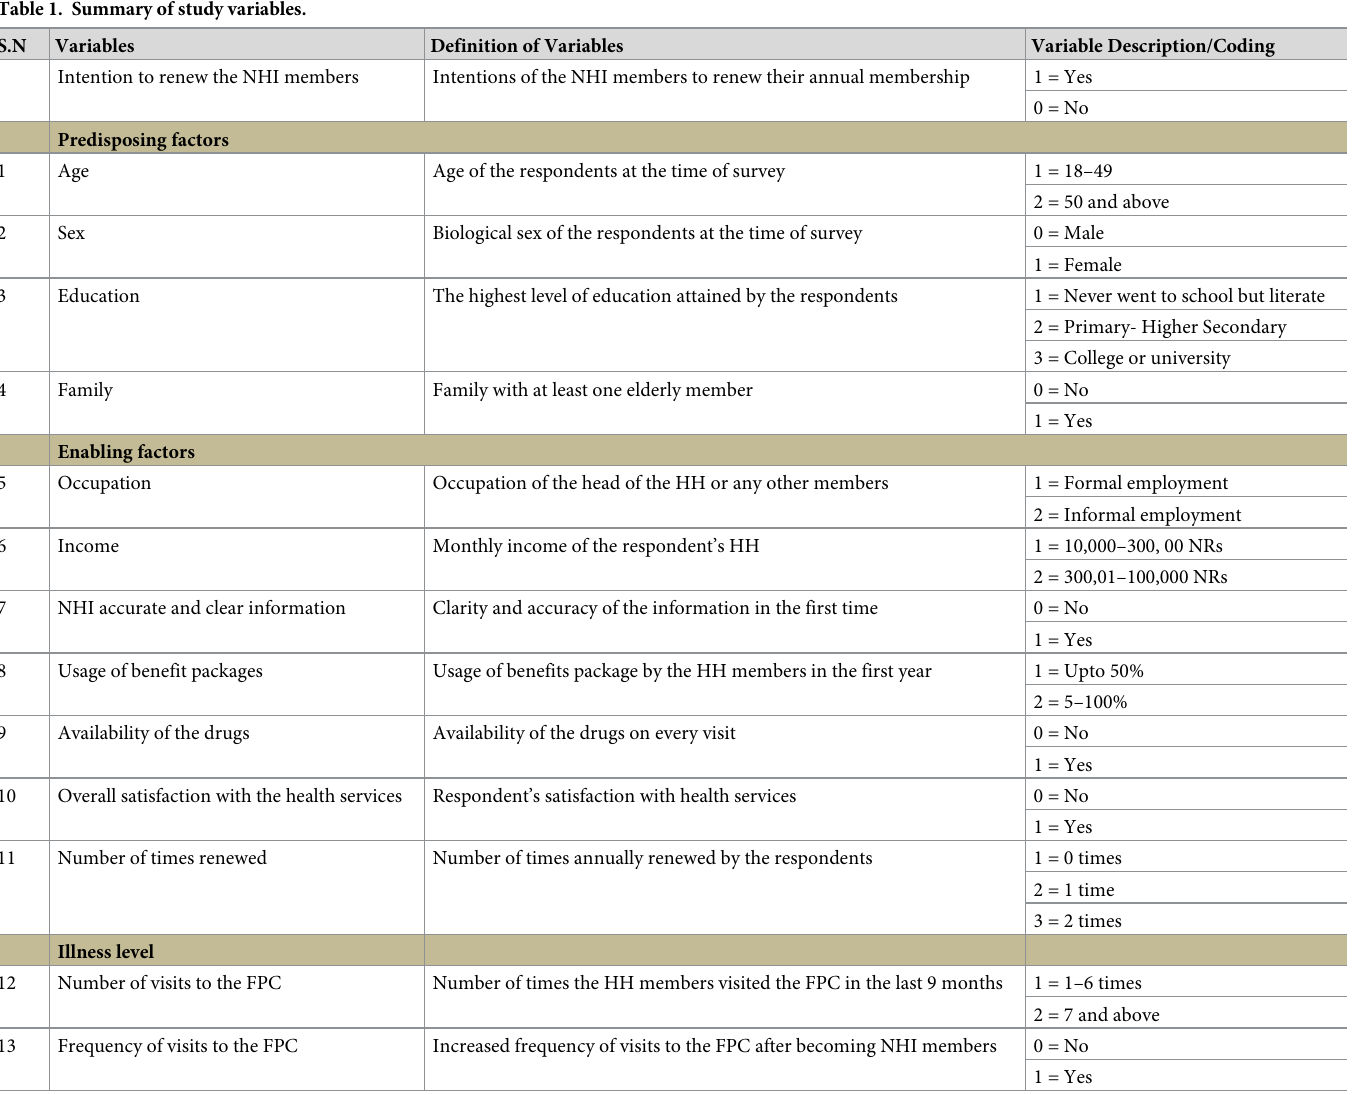
Table 1. Summary of study